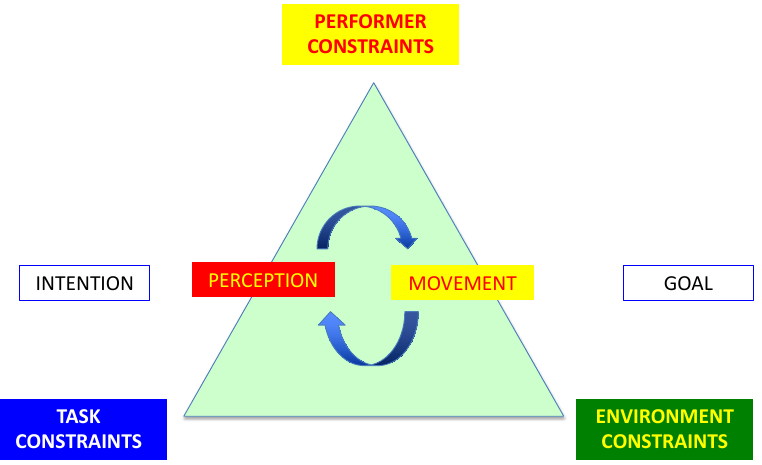
Figure 1. The ecological-dynamic model (Redrawn from the constraints-based approach to motor learning: Implications for a non-linear pedagogy in sport and physical education [39]). Medical and anesthetic tasks, such as intubation, intravenous cannulation, the in- sertion of a spinal needle, laparoscopy, and gut endoscopy, are composed of identifiable sequential steps. Each step represents a sub-goal (intention). An active perception of affordances links in a continuous cycle with movements to achieve the goal. Movements emerge from an interaction of constraints within a complex system consisting of performer (learner), environment, and